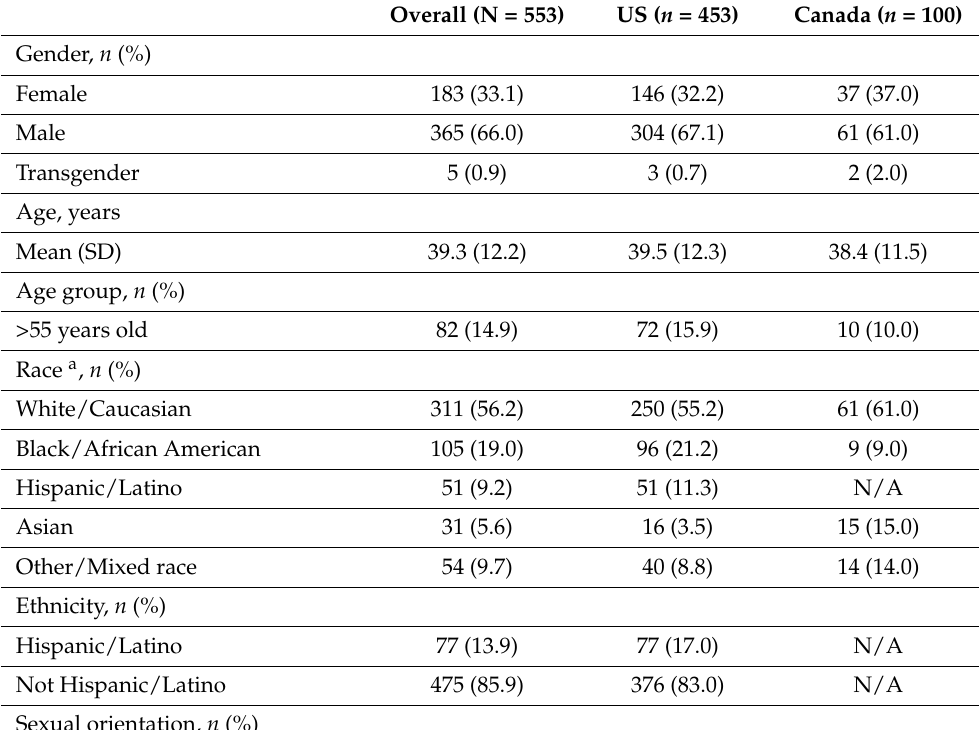
Table 3. Sociodemographic and clinical characteristics of